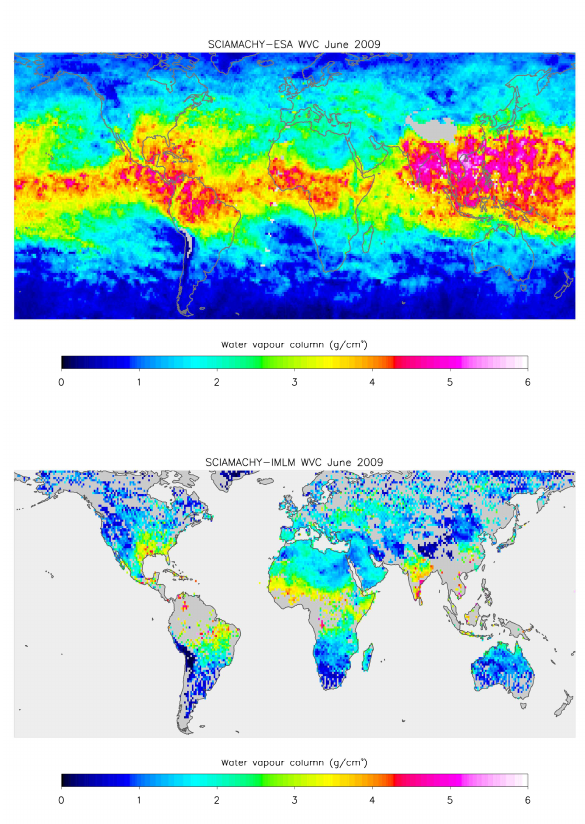
Fig. 15. SCIAMACHY-ESA (top) and SCIAMACHY-IMLM (bot- tom) averaged WVC amounts for the month of June 2009. In both figures each WVC product’s own suggested selection criteria are used: SCIAMACHY-ESA WVC measurements are for all cloud conditions over land and ocean surfaces, and SCIAMACHY-IMLM WVC measurements are filtered according to the suggested criteria whereby only cloud-free cases over land are included, with signal level strengths larger than or equal to 100BUpx − 1